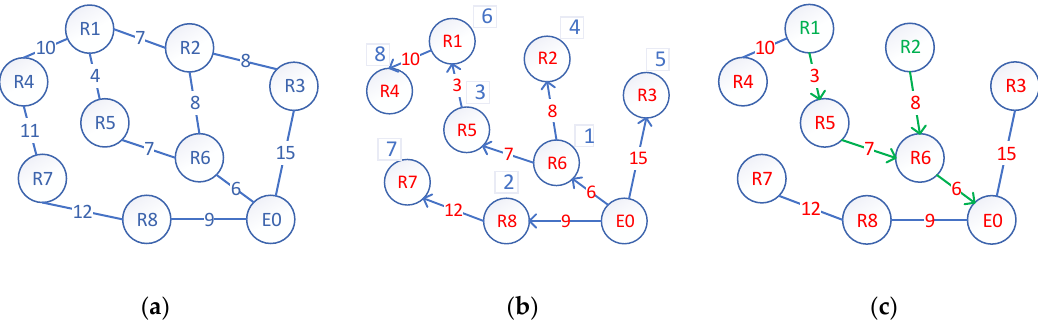
Figure 6. Illustration of generation of the shortest path tree and convergence of two escape groups. ( a ) Indoor evacuation network; ( b ) Shortest path tree; ( c ) Two shortest paths with intersection.